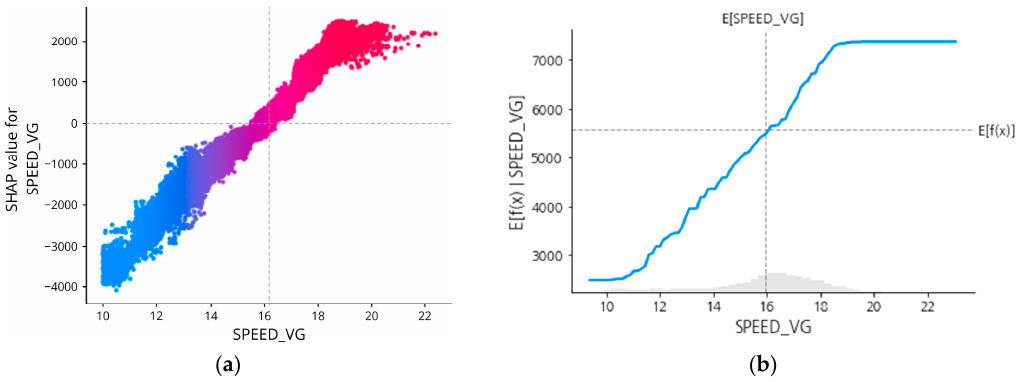
Figure 9. SHAP dependence plot ( a ) and partial dependence plot ( b ) of SPEED_VG.